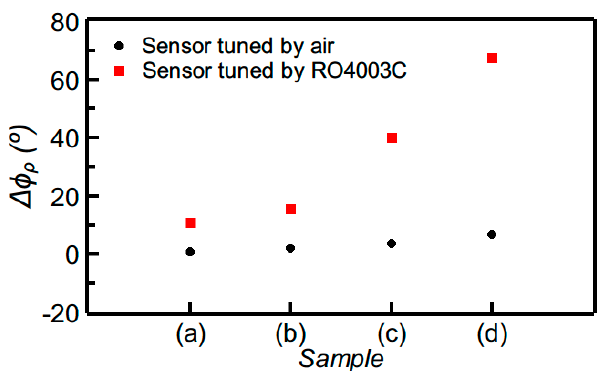
Figure 8. Comparison of the measured differential phase of the reflection coefficient for sensor A and for the equivalent sensor, but with the sensing line exhibiting a phase of 90° when it is uncovered (i.e., tuned by air).